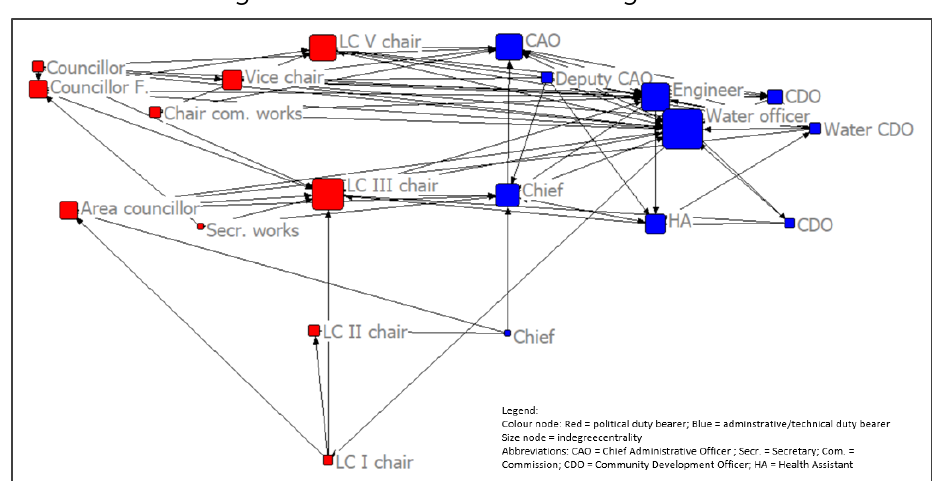
Figure 3c: Actual information-sharing